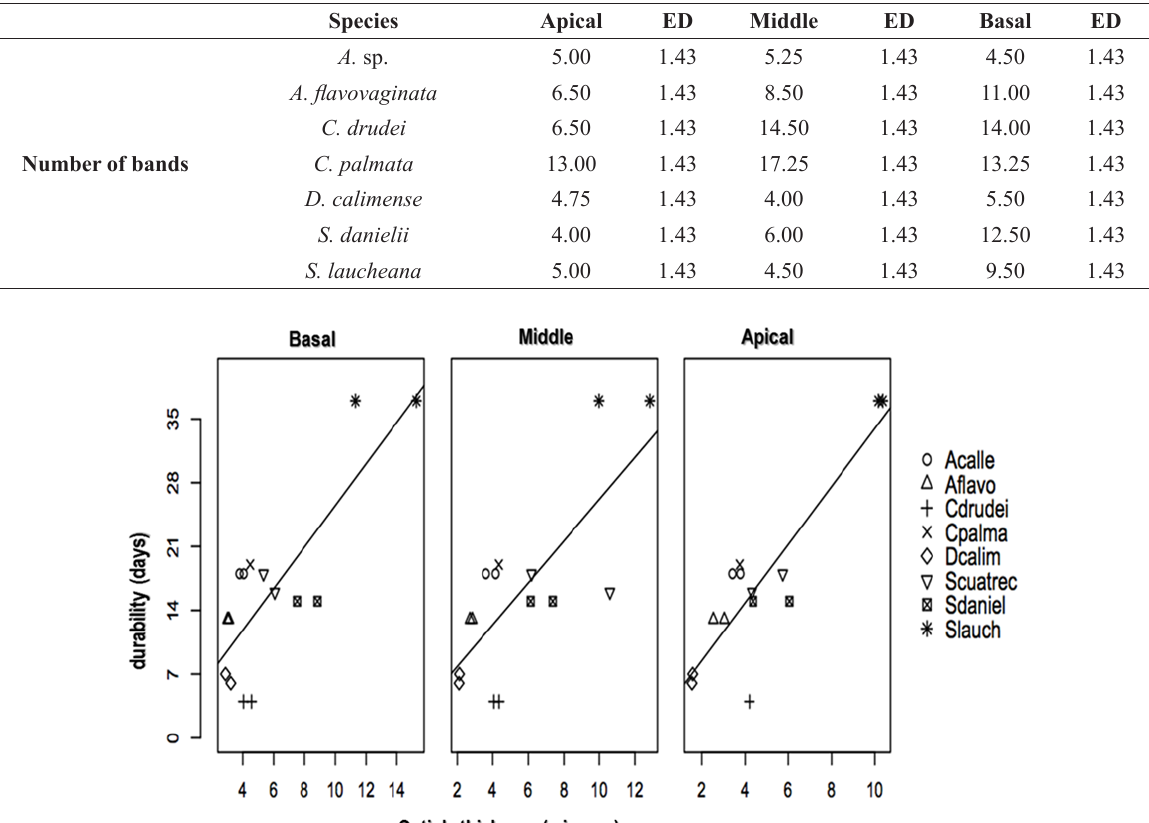
Figure 2 - Relationship between the mean values of cuticle thickness and durability in vase for eight species of Cyclanthaceae. See name species in Table